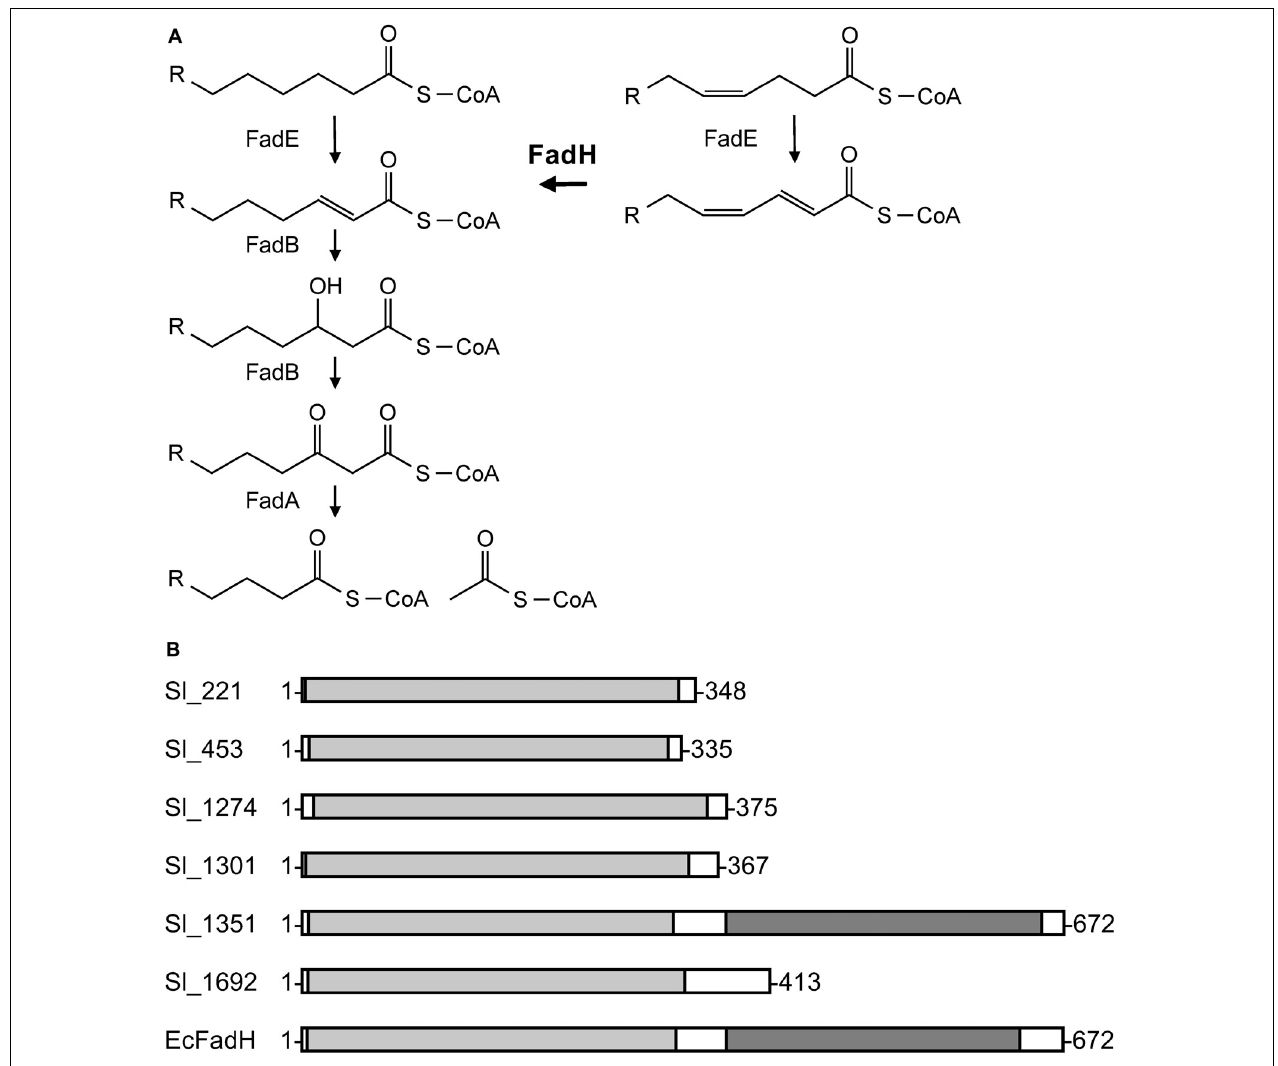
FIGURE 3 | General β -oxidation reactions (A) and the domain structures of the six FadH homologs (B) . (A) FadE, acyl-CoA dehydrogenase; FadB, enoyl-CoA hydratase/3-hydroxyacyl-CoA dehydrogenase; FadA, 3-ketoacyl-CoA thiolase; and FadH, 2,4-dienoyl-CoA reductase. (B) The image was generated on the MOTIF Search website (https://www.genome.jp/tools/motif/) and modified. The light gray represents a catalytic domain and the dark gray NAD(P)H-binding domain. EcFadH represents FadH from E. coli